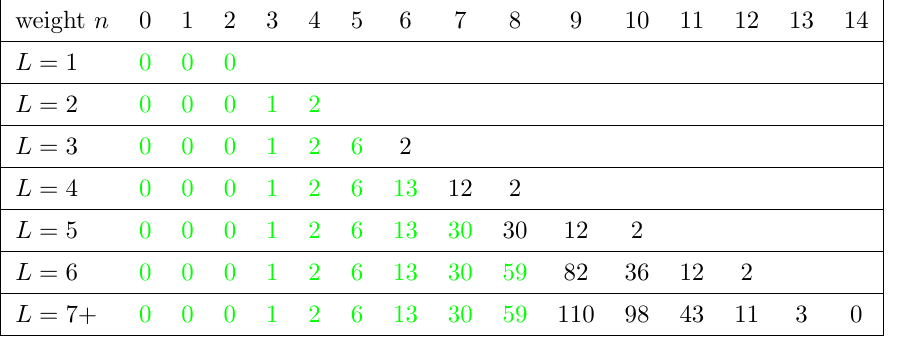
Table 5 . Same as table 4, but just the parity odd f n; 1 ; 1 ; : : : ; 1 g coproducts of the MHV and NMHV amplitudes. Note that saturation of the odd functions now begins two loops earlier.